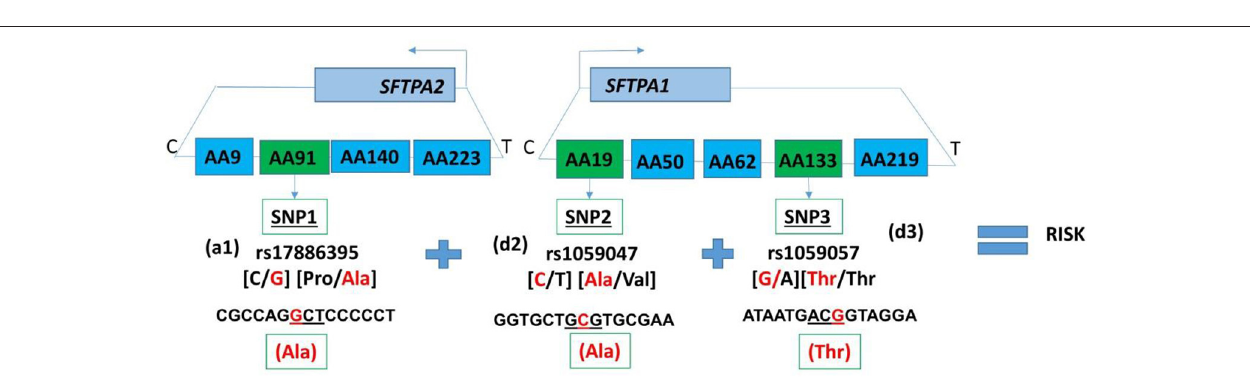
FIGURE 2 | Intergenic three SNP interaction and RDS susceptibility. It shows the schematic presentation of SFTPA2 and SFTPA1 on the top and the arrows depict the opposite transcriptional orientation. The relative location of SNPs is shown from centromere (C) to telomere (T) and each box represents the amino acid number that includes the particular SNP. For example, AA91 denotes the rs17886395 SNP, AA19 denotes the rs1059047 SNP, and AA133 denotes the rs1059057 SNP. In this three SNP intergenic interaction, underneath the green boxes are the SNP ID and the SNPs involved. The additive effect of SNP1, rs17886395G variant that codes for alanine (highlighted in red) interacts with SNP2 and SNP3 of SFTPA1 in a dominant effect and increases risk of